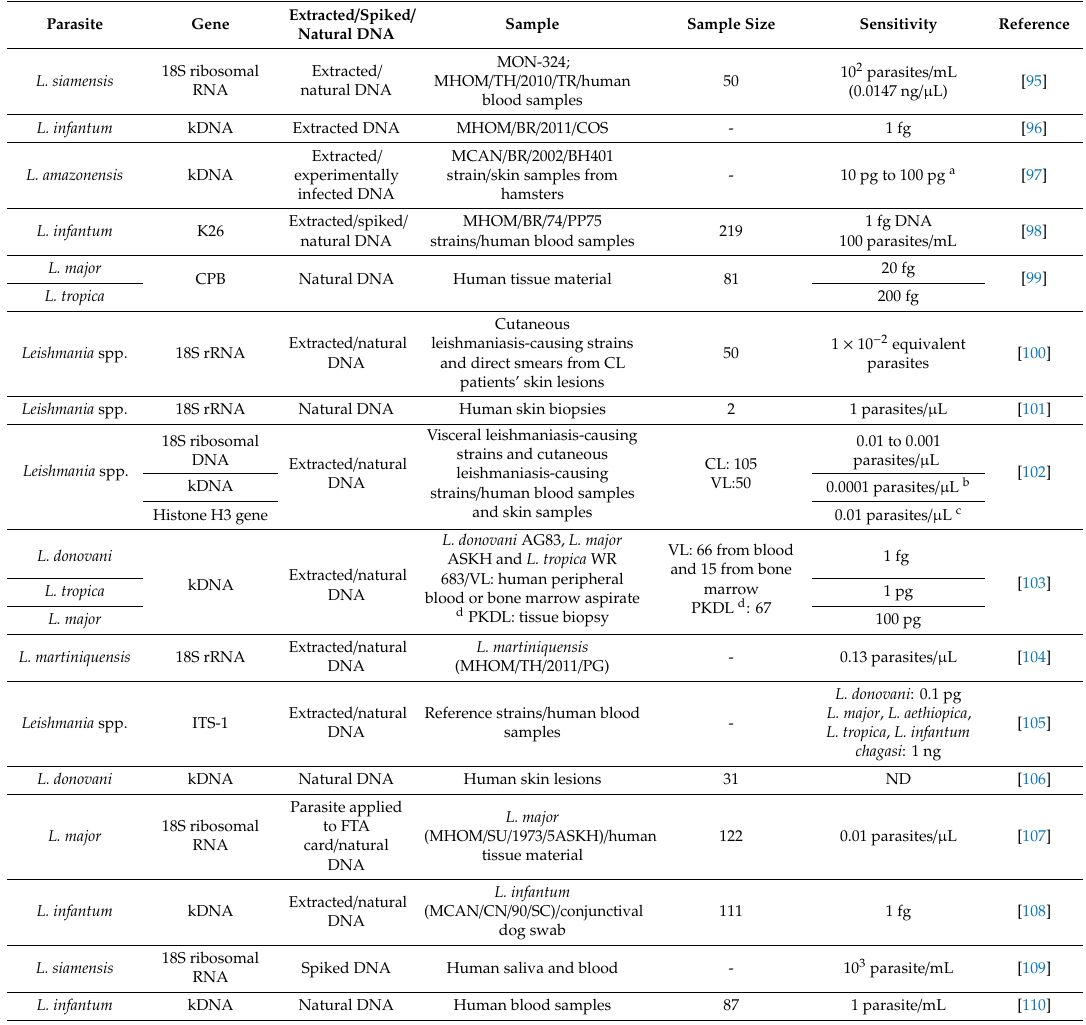
Table 8. Publications found in the US National Library of Medicine National Institutes of Health (NCBI-PubMed) reporting the standardisation of the LAMP technique as a useful tool for diagnosing leishmaniasis in the definitive